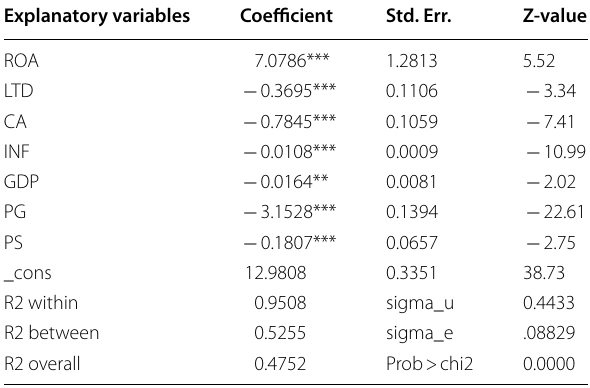
Table 4 Heteroskedasticity test